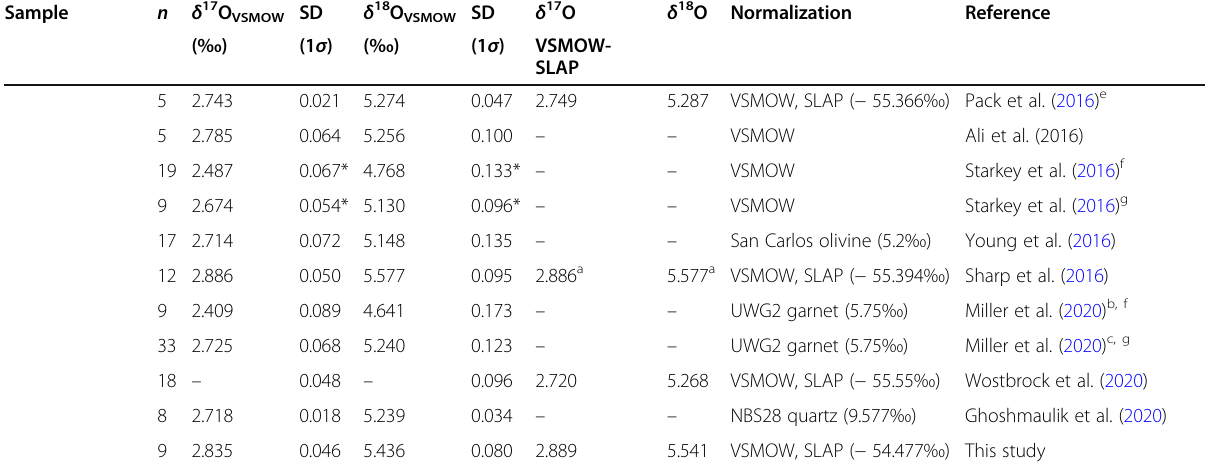
Table 3 Literature data of δ 17 O and δ 18 O for the international silicate standards and normalization methods (Continued)